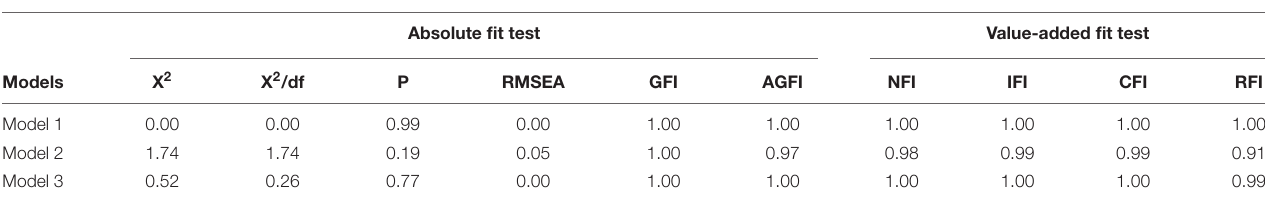
TABLE 3 | The fit measures of model